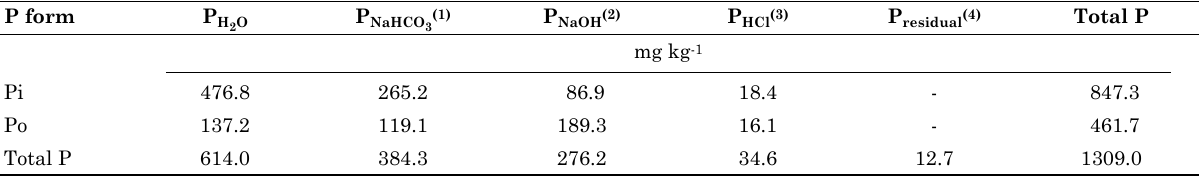
Table 1. Inorganic (Pi) and organic (Po) P fractions of cattle manure P form P H 2